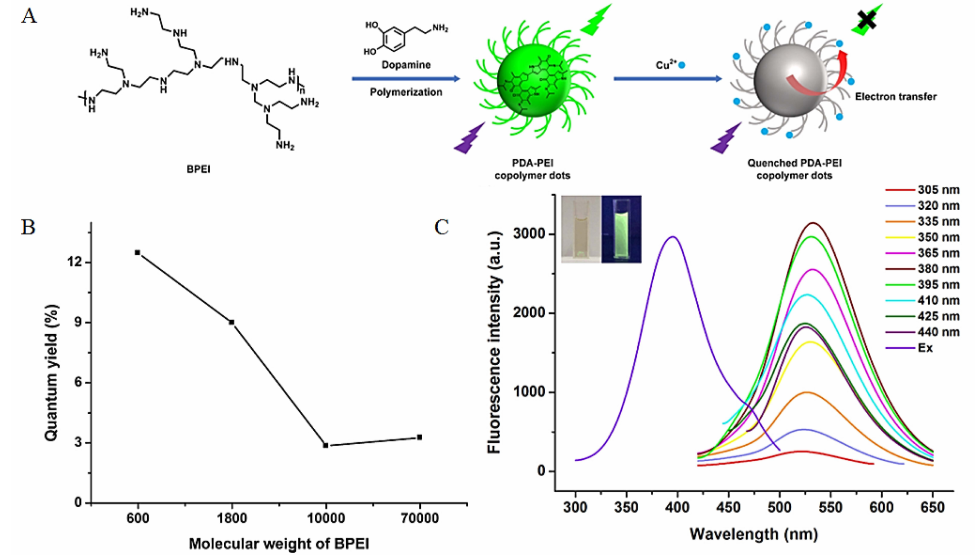
Figure 2. ( A ) Schematic diagram of the synthesis of PDA-PEI copolymer dots and the determination of Cu 2+ . ( B ) QY of PDA-PEI under the different molecular weights of BPEI ( C ) PL spectra [35]. Reprinted/adapted with permission from Ref. [35]. 2019